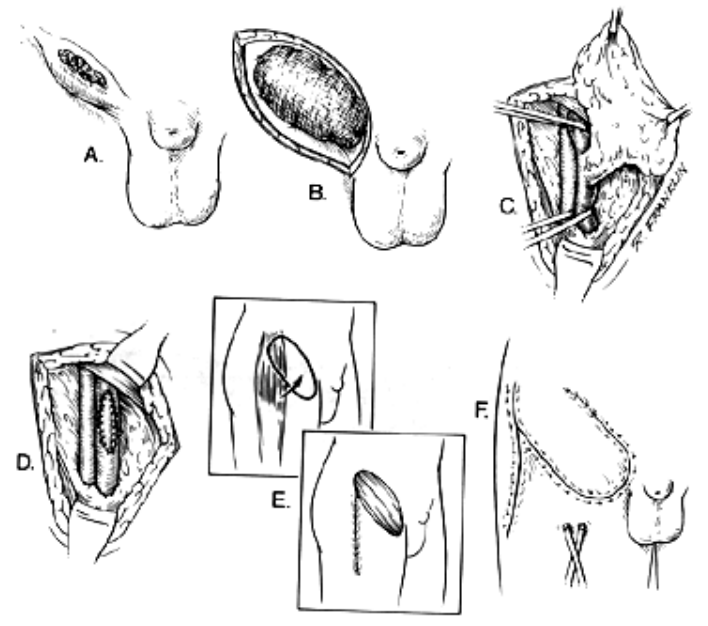
FIGURE 8. Excision of an enlarged, ulcerated node. (A) Ulcerated node in groin. (B) Tumor covered with gauze and dissected with a 2-cm margin of normal skin. (C) Dissection of the femoral vessels with demonstration of tumor invasion of the femoral vein. (D) View following excision of tumor with saphenous vein patch in place on the femoral vein. (E) Rotation of tensor fascia lata as a myocutaneous flap to cover groin defect. (F) Closure of groin with myocutaneous